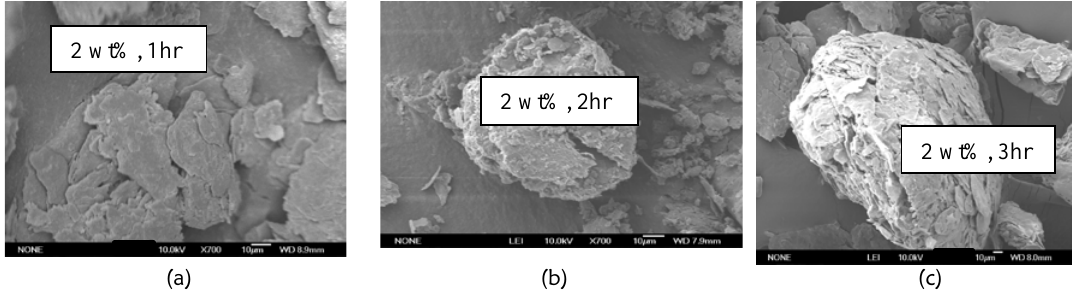
Figure 4: Microstructure and morphology of 2 wt% CNT at 250 rpm for different ball milling time